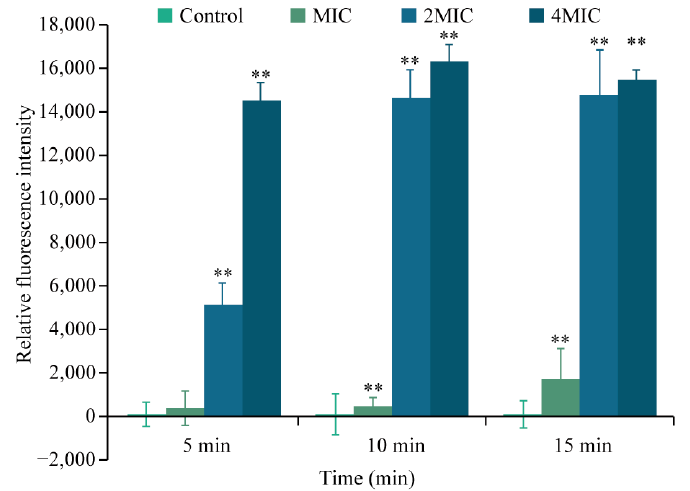
Figure 7. Changes in cell membrane potential of Sh. flexneri treated with eugenol. ** indicates statistical significance of p < 0.01 compared with the control.